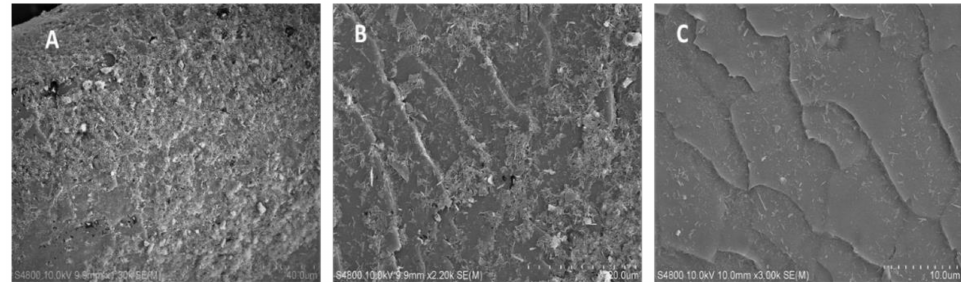
Figure 10. SEM images of drug-HNT composite deposited on goat hair (no washing) ( A ), hair washed one time after the clay deposition ( B ), and hair washed two times after deposition ( C ). Table 5. Mortality response of permethrin-halloysite (HNT) composites on D. caprae lice with first and second hair wash. Number of Lice Survived/Time Experimental Formulation